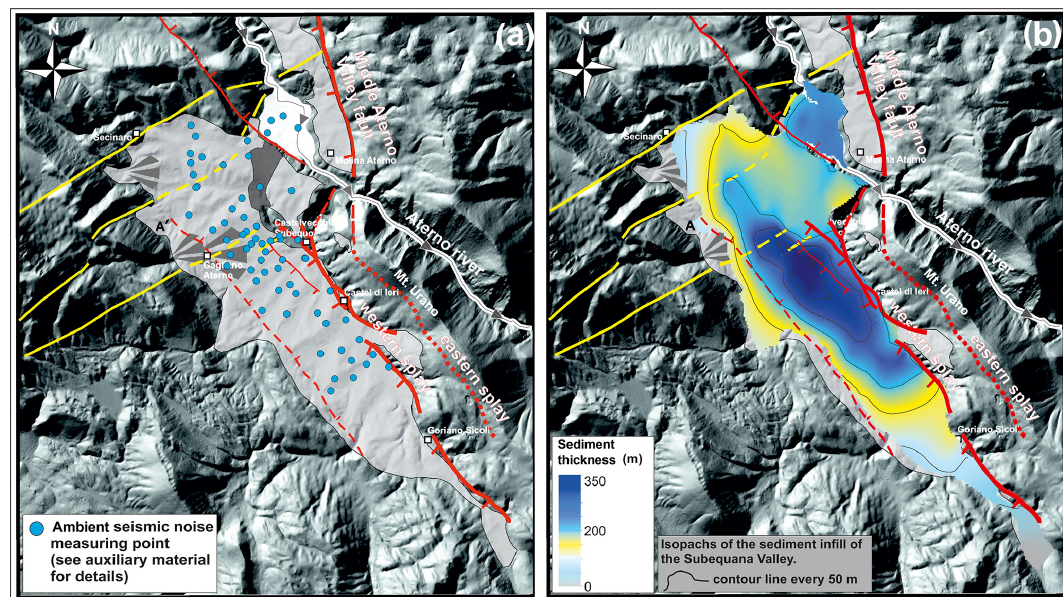
Figure 7. (a) Simplified geological map of the Subequana Valley (legend as in Fig. 2); location of the ambient seismic noise measuring points, blue circles. (b) Reconstruction of the deep geometry of the Subequana Valley (legend as in Fig. 2), defined by the sedimentary infill